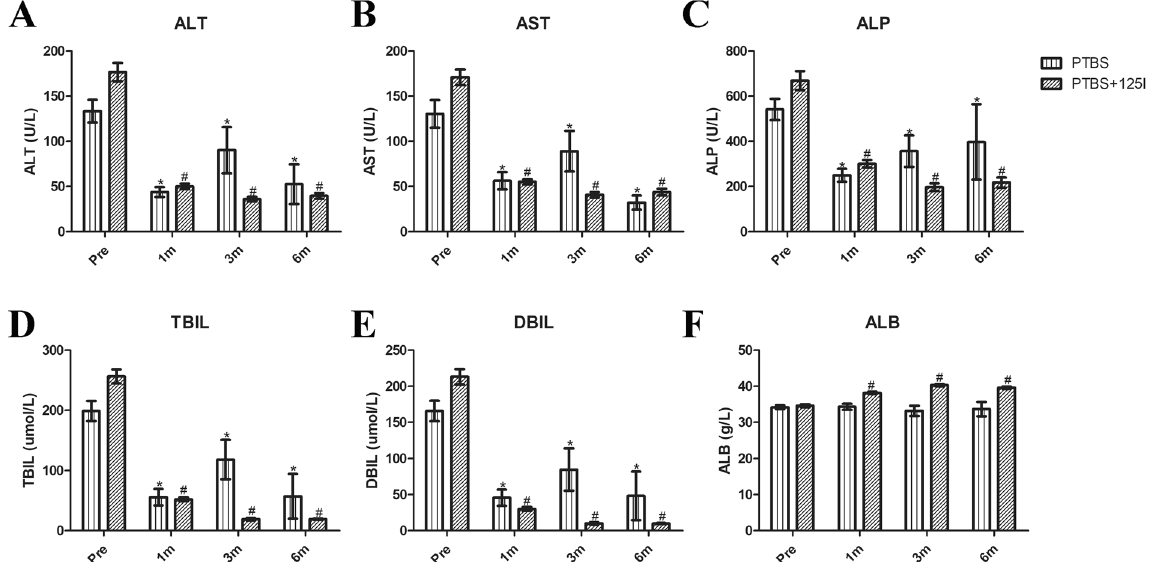
Figure 1. Changes of liver function after operation in the PTBS and PTBS + 125 I groups. Changes of ALT ( A ), AST ( B ), ALP ( C ), TBIL ( D ), DBIL ( E ), and ALB ( F ) at 1 month, 3 months and 6 months post-operatively ( * p < 0.05 compared with preoperative values in the PTBS group; # p < 0.05 compared with preoperative values in the PTBS + 125 I group).